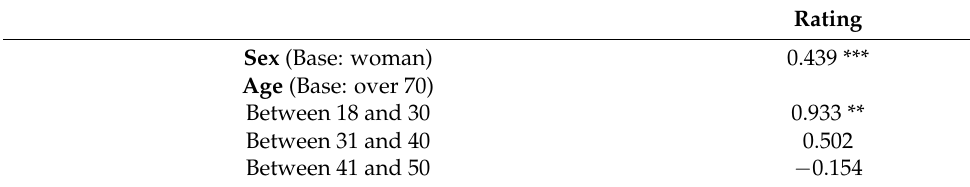
Table 3. Ordinal logistic regression. Assessed state of